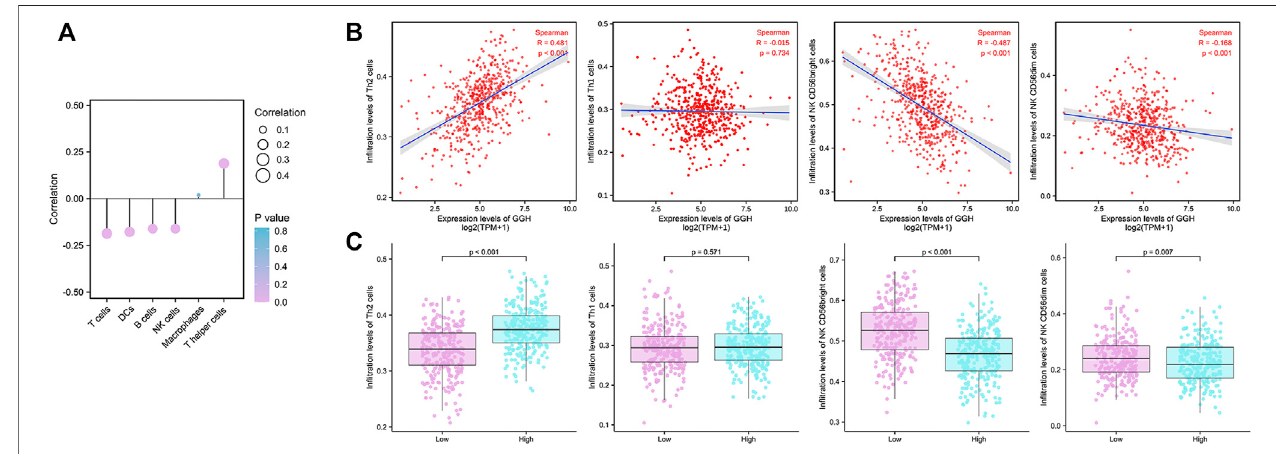
FIGURE 8 | Associations between GGH mRNA expression level and in fi ltration of various immune cell types into the UCEC tumor microenvironment. (A) Correlations between GGH expression level and the relative abundances of the indicated immune cells. Dot size indicates the absolute Spearman correlation coef fi cient (R), and the color gradation from blue to pink indicates low to high p -value. (B) Correlations between the relative enrichment scores of individual immune cell type genes and GGH expression level. (C) Comparisons of immune cell in fi ltration between high and low GGH expression